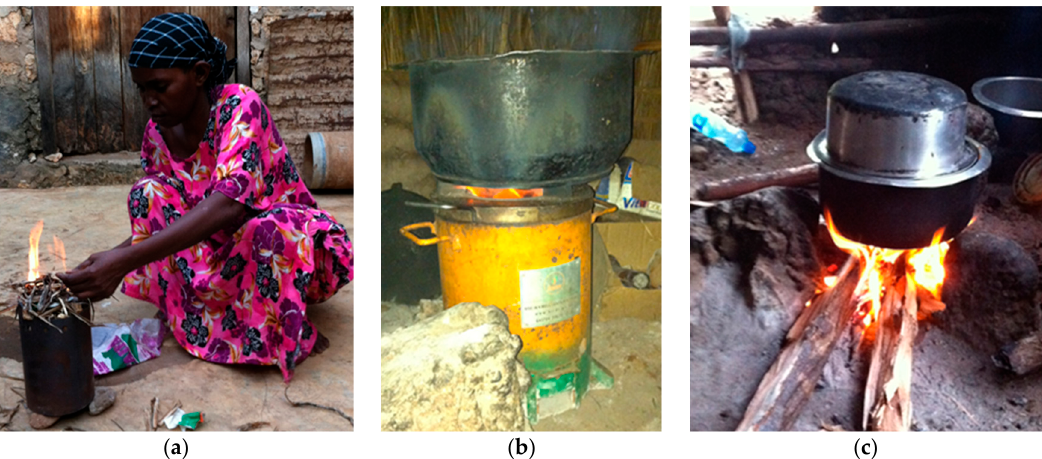
Figure 2. ( a ) Lighting fuel in a canister outside; ( b ) cooking with gasifier; and ( c ) cooking with three-stone open fire.